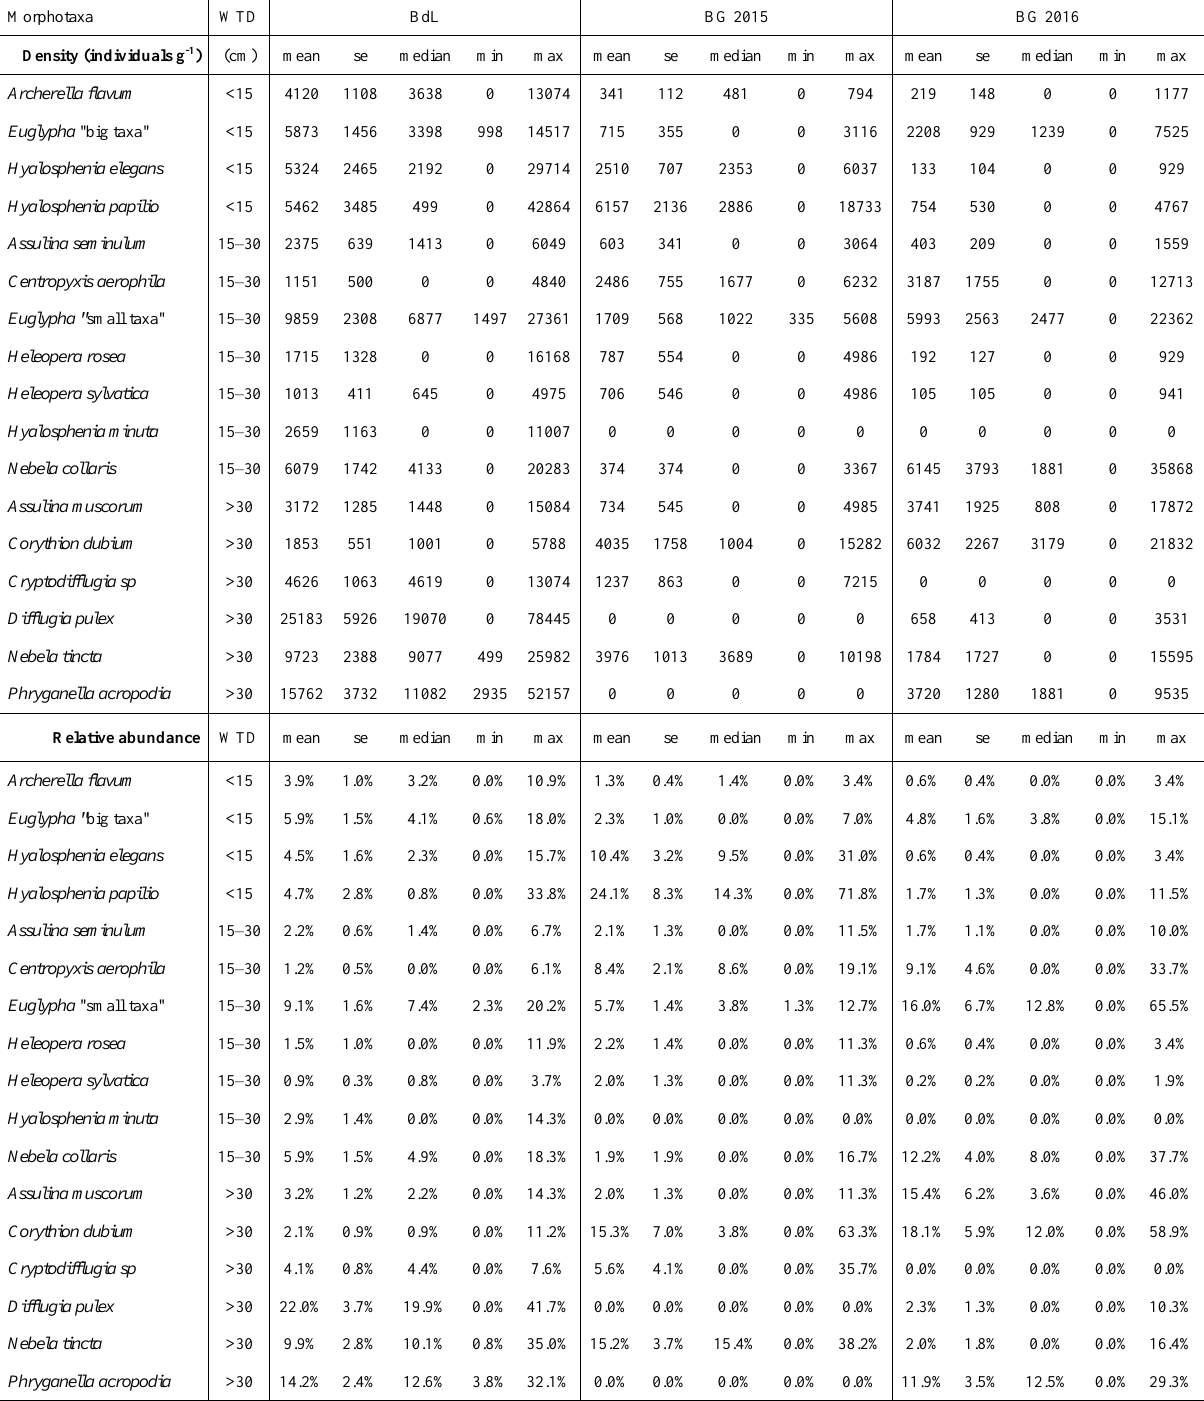
Table 2: Descriptive statistics of testate amoeba communities (dead and living pooled together) from the experimental bog in Neuchâtel Botanic Garden (BG) and the Bois-des-Lattes peatland (BdL), with density ( per gram of dry Sphagnum ) (upper table) and relative abundance (lower table) presented separately for each site. Morphotaxa are ordered according to water table depth class (WTD, estimated on the basis of previous studies in Europe (Mitchell et al . 1999, Lamentowicz & Mitchell 2005, Lemonis 2012); se = standard error. Morphotaxa WTD BdL Density (individuals g -1 )